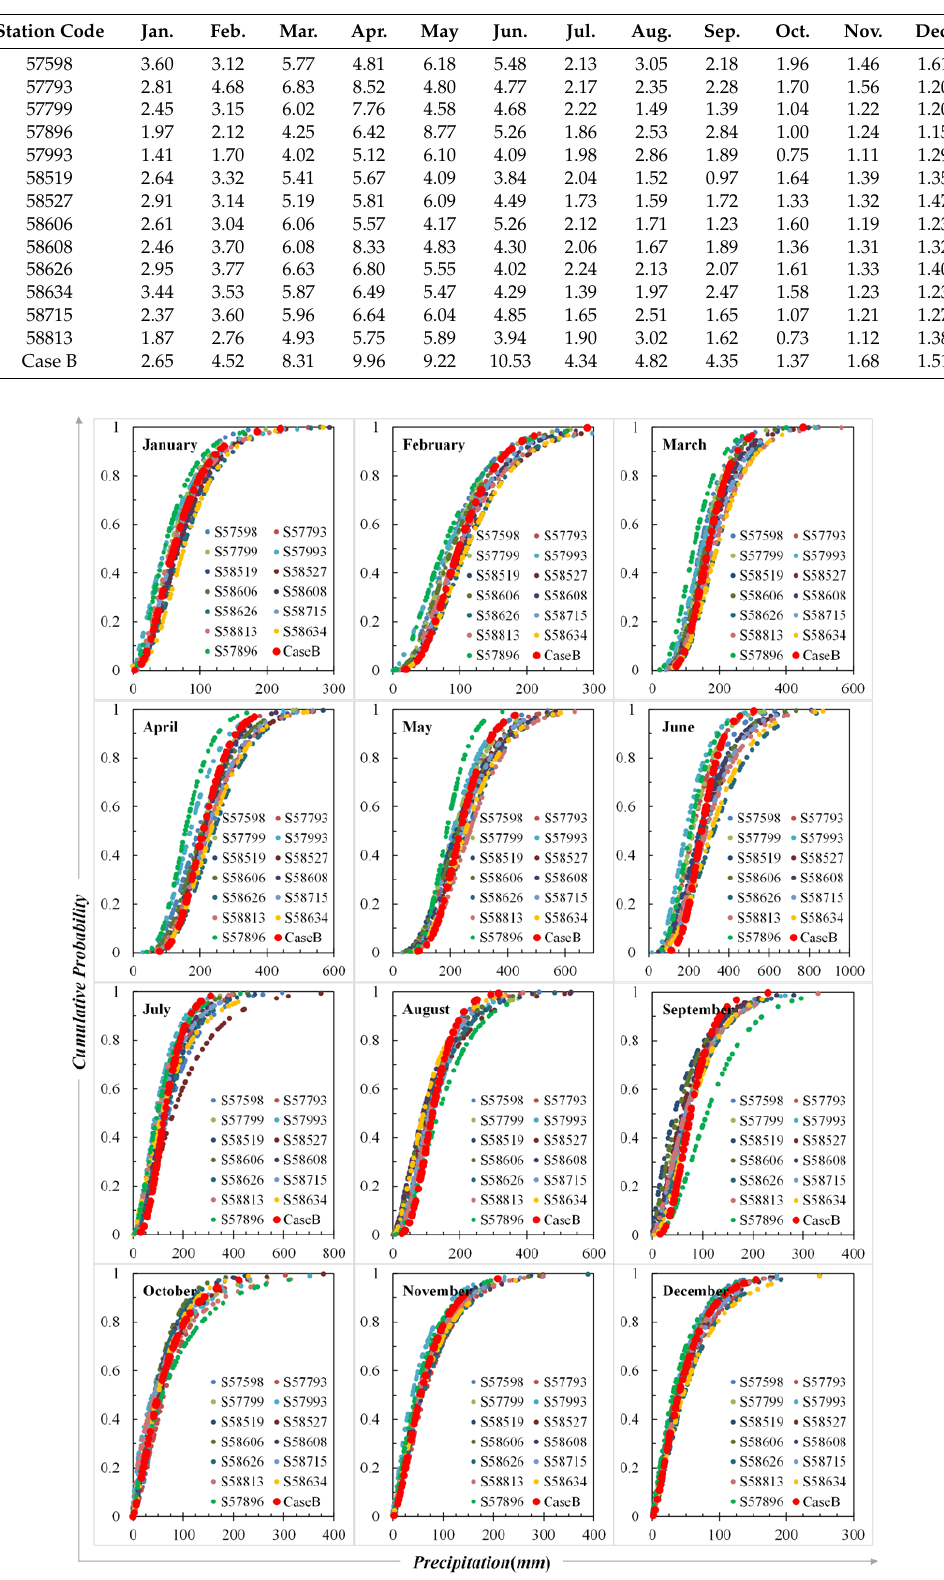
Figure 2. The precipitation-cumulative probability curves of stations selected and the precipitation-average scheme in